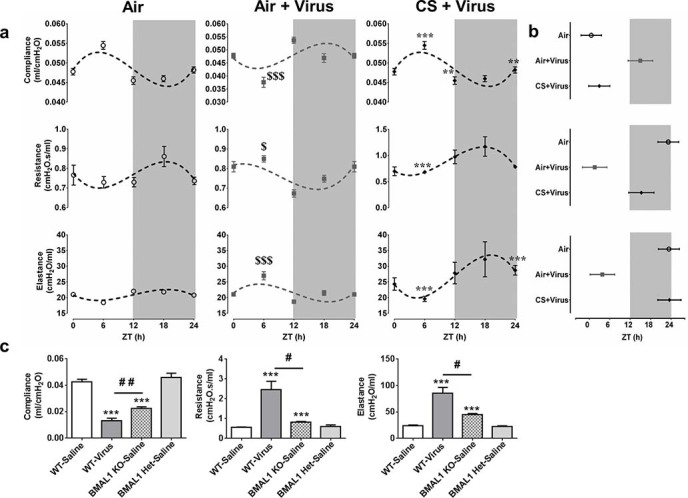
Daily rhythms of lung function are differentially affected by chronic
CS-exposure and influenza A virus infection.Data from chronic (6 months) air- or CS-exposed WT mice given intranasal
inoculation of either saline (control group) or influenza A virus (IAV;
treatment group) at ZT4-6 are shown. Data from uninfected air-exposed mice
from a previous experiment were included for comparison [panels
a–b;30]. (a) Daily
rhythms of compliance, resistance and elastance were measured in air,
Air+Virus and CS+Virus mice. As in previous experiments, measurements were
taken on day 9 post-infection. (b) COG or peak phase values for each
measure of lung function were plotted on a horizontal phase map. Gray
shading in panels a and b indicates the relative dark phase (ZT12-24). Data
from air-exposed (open circle), Air+Virus (gray square) and CS+Virus (solid
diamond) are representative of mean ± SEM (n = 3-4 mice/group)
for each time point. ** P < 0.01; *** P
< 0.001, significant compared to Air+Virus; $
P < 0.05; $$$
P < 0.001 significant compared to air-exposed mice.
(c) Influenza A virus infection altered lung function in WT mice.
After day 9 post-infection, lung compliance, resistance and tissue elastance
were determined in WT-Saline, WT-Virus, BMAL1 KO-Saline and BMAL1 Het-Saline
(heterozygous) treated mice. Data are representative of mean ±
SEM (n = 10 WT-Saline; n = 8 WT-Virus, n = 4 BMAL1 KO-Saline and n = 6 BMAL1
Het-Saline) for each time point. *** P < 0.001,
significant compared to WT-Saline; #
P < 0.05; # #
P < 0.01 significant compared to WT-Virus.